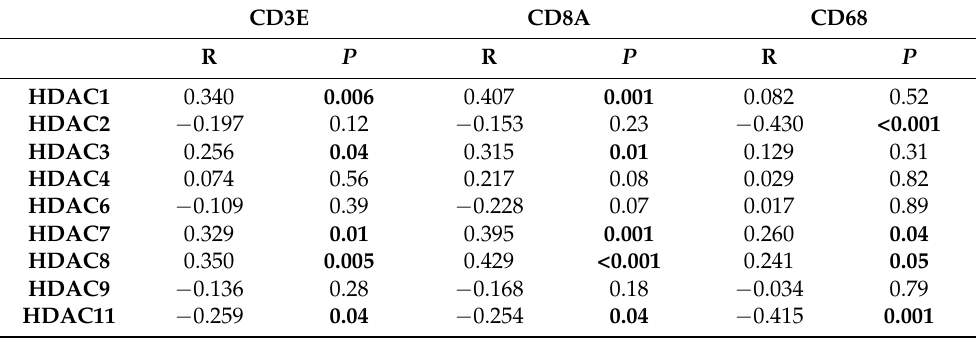
Table 3. Correlation between mRNA expression levels (determined by Illumina array) of different HDACs and expression of TILs (CD3E and CD8A) and TAMs (CD68) in the LUMC cohort ( n = 64). R = two-tailed Spearman correlation coefficient. p ≤ 0.05 is considered significant (indicated in bold). CD3E CD8A CD68 R P R P R P